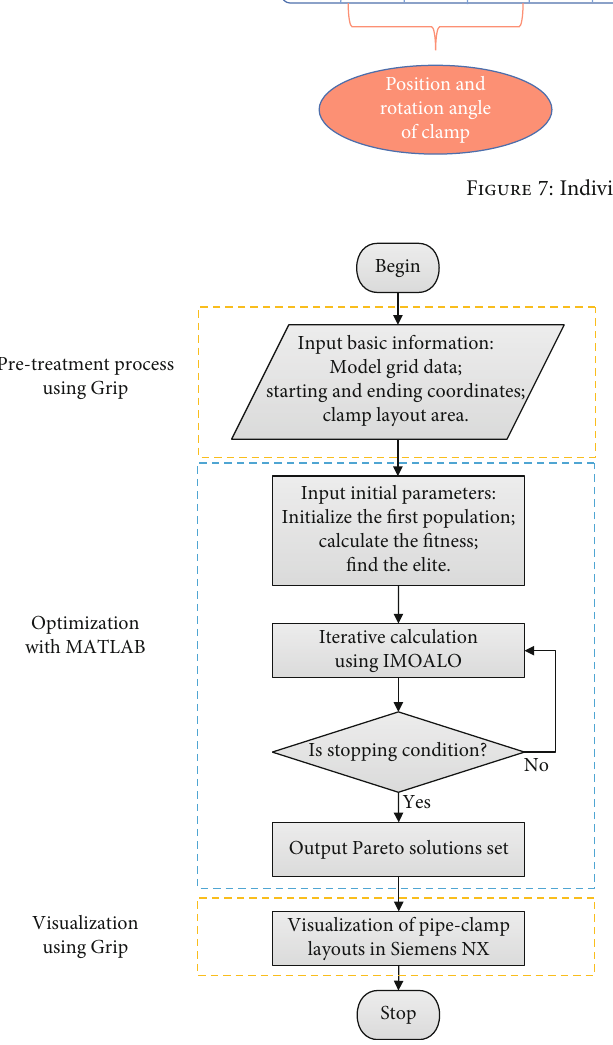
Figure 8: The fl owchart of layout method.